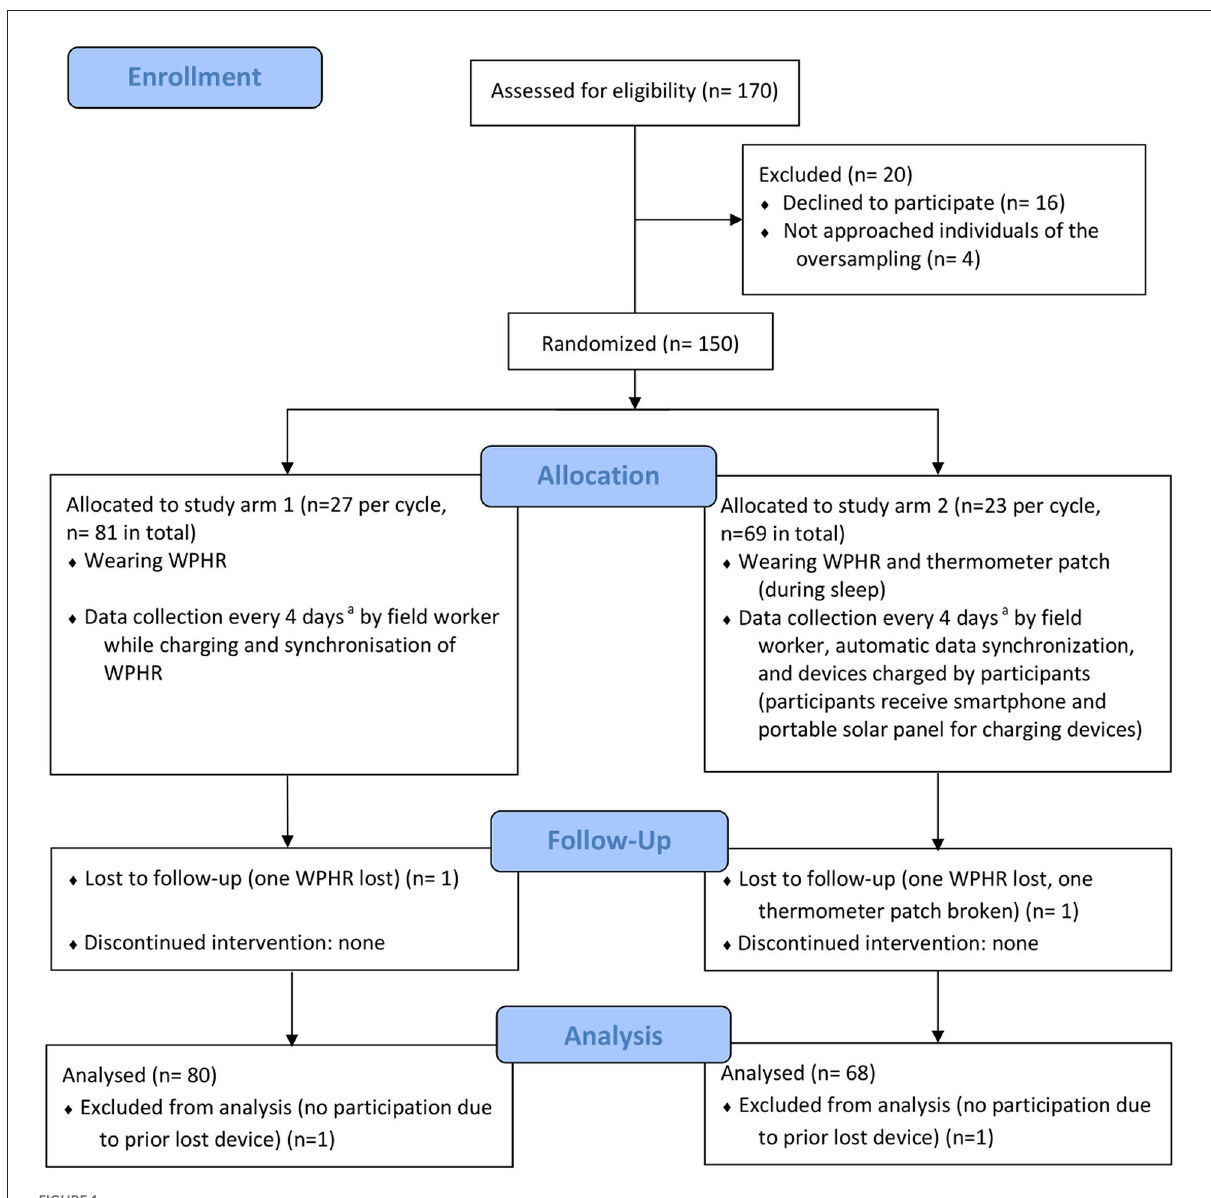
FIGURE1 CONSORT flow diagram (28) ( a depending on weekends and public